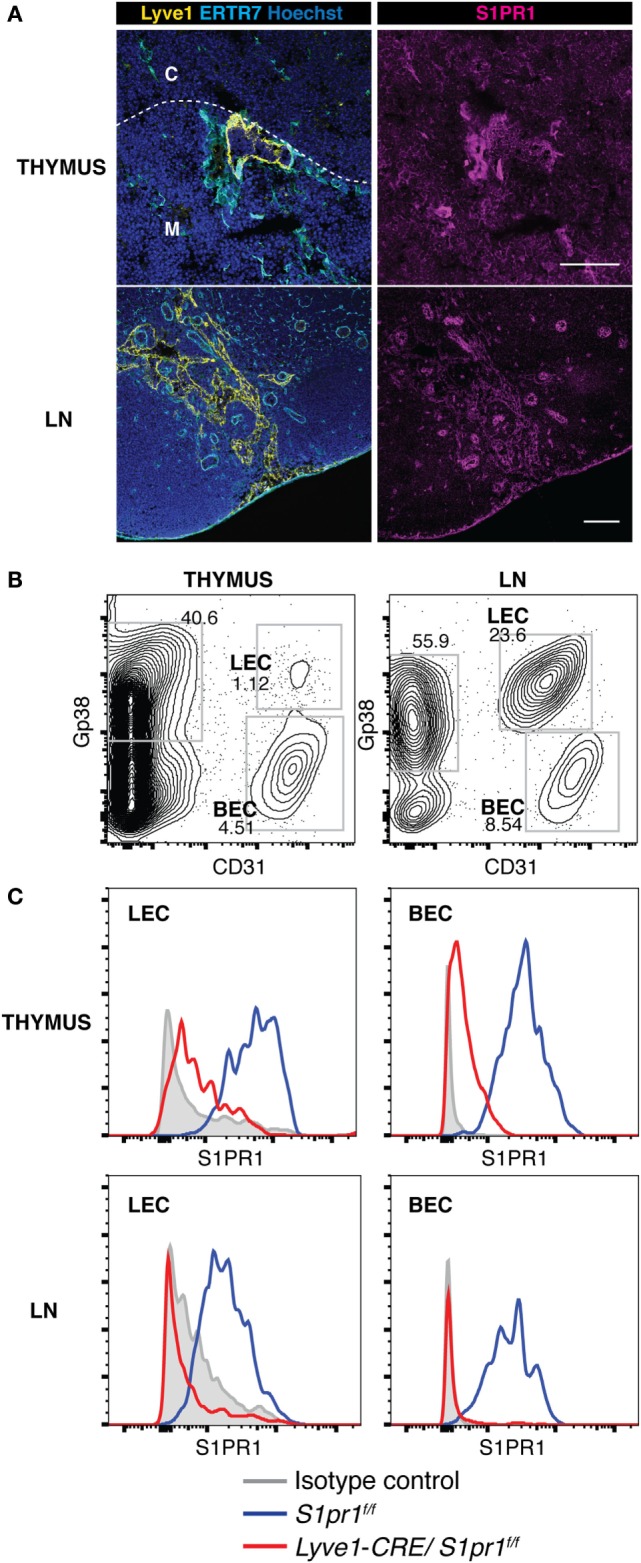
S1PR1 is expressed in lymphatic endothelial cells of the thymus and LNs. (A) S1PR1 expression was examined immunohistologically in the thymus and LNs. Lyve1-positive lymphatics were observed in the vicinity of the cortico-medullary junction (dotted line). C, cortex; M, medulla. Bars, 100 μm. (B,C) Flow cytometric analysis of S1PR1 expression in thymic and LN stromal cells of S1pr1f/f and Lyve1-CRE/S1pr1f/f mice. (B) CD45-negative stromal cell populations from the thymus and LNs. Lymphatic and blood vessel endothelial cells (LECs and BECs) were identified by their expression of Gp38 and CD31. (C) S1PR1 expression in LECs and BECs in the thymus and LNs of S1pr1f/f (blue line) and Lyve1-CRE/S1pr1f/f mice (red line). Data are representative of two (A) or three (B,C) independent experiments.